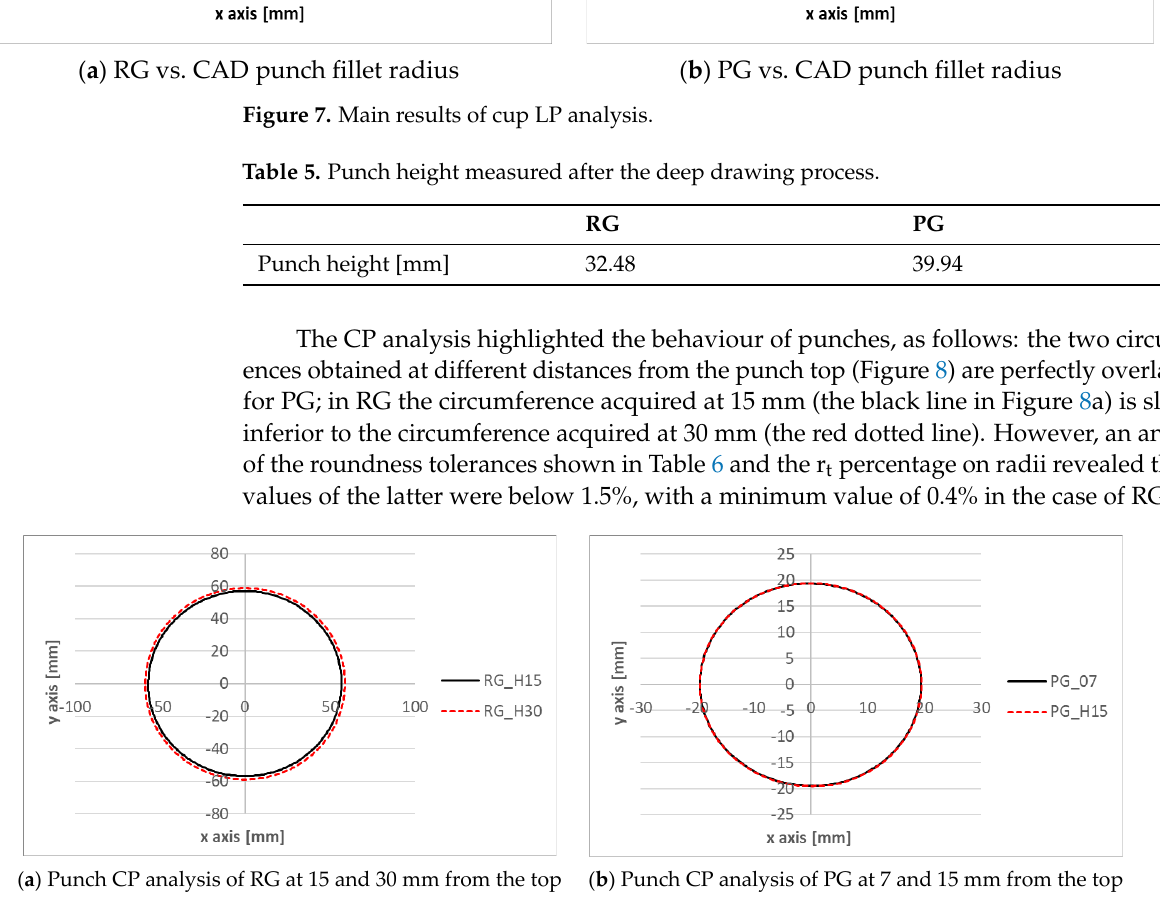
Table 6. Main results of punch CP analysis.